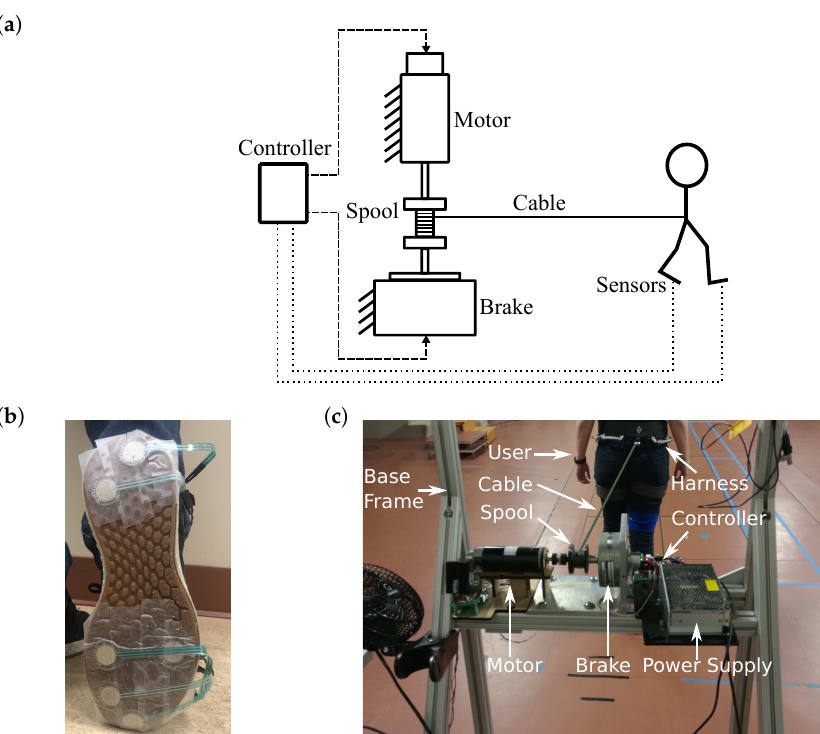
Figure 1. Schematic and a prototype of the proposed GPT. ( a ) GPT schematic. A person is tethered to a spool, which is connected to a motor and a brake. Dashed lines represent wired connections, and dotted lines show wireless data transmission. ( b ) Event switches on a shoe sole. ( c ) The stationary device. The cable is digitally enhanced to increase